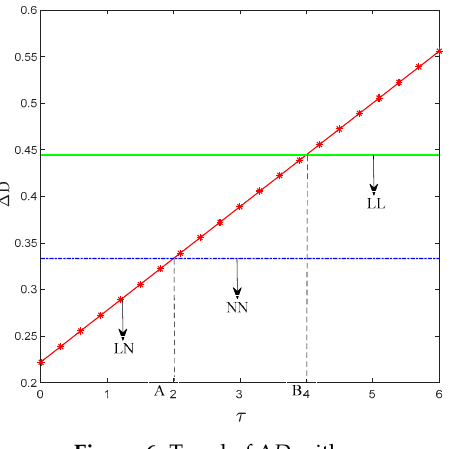
Figure 6. Trend of Δ D with τ .